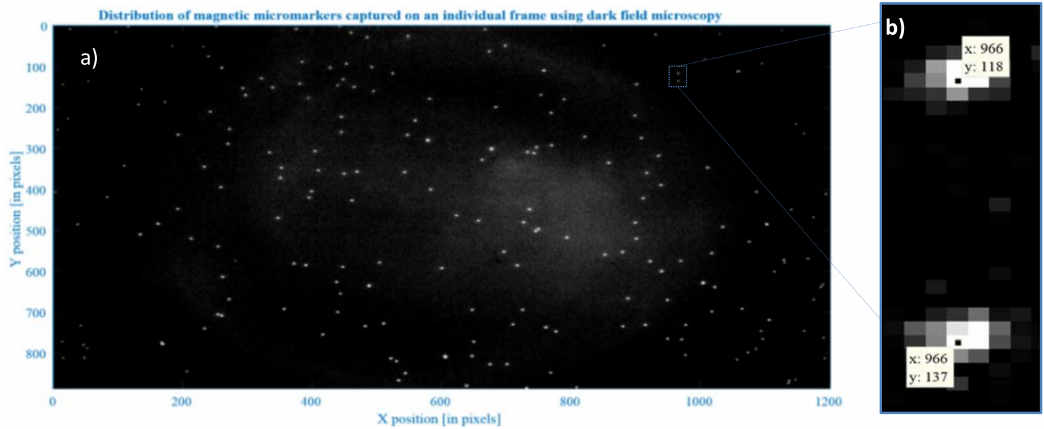
Figure 3. Magnetic micromarkers appear as bright spots on a dark background image. ( a ) multiple microparticles captured on a single frame i and ( b ) close-up for two particles with centroids assigned to each particle. For every frame, the coordinates xi and yi of the particles’ centroids are